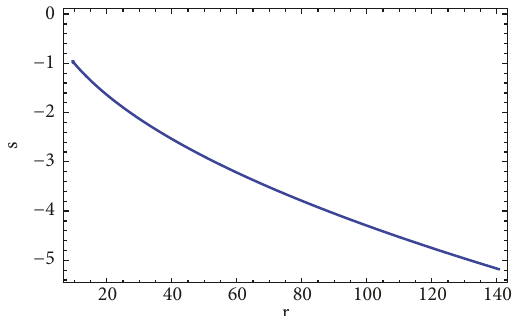
Figure 4: Plot of state-finder diagnostic parameters for 𝜆 = 2.4 .